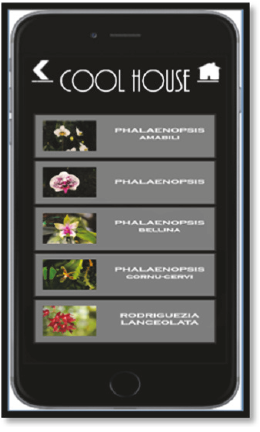
Figure 4: Information associated with points of interest markers.